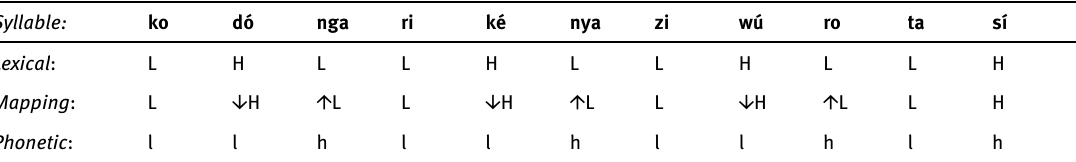
Table 3: Tone sandhi mapping in Tem (↓H: downstepped high tone; ↑L: upstepped low tone; upper case: phonological tone; lower case: phonetic